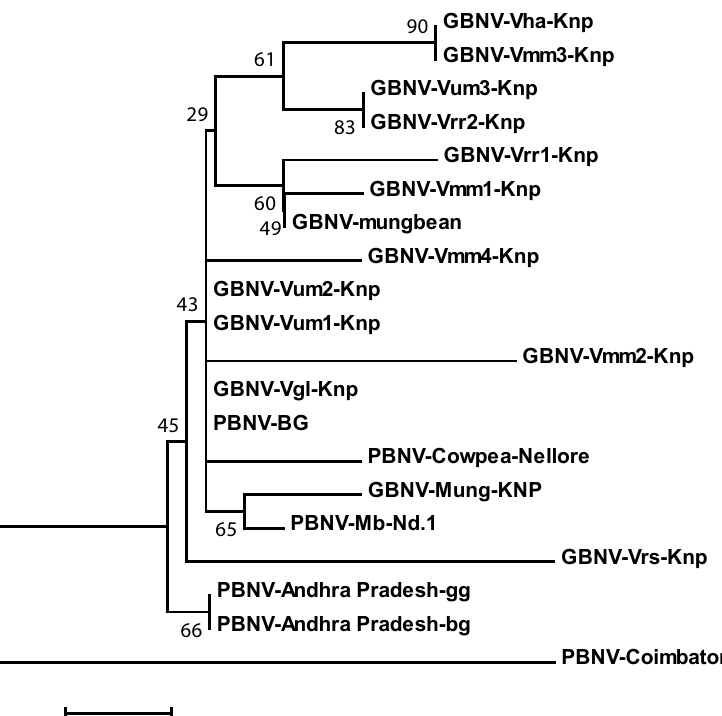
Figure 2. Phylogeny was inferred using Neighbor-Joining method of the GBNV isolates obtained in this study from wild Vigna species and sub-species and the GBNV isolates from Vigna species already available. The optimal tree with the sum of branch length = 0.12182971 is shown. The evolutionary distances were computed using the p-distance method and are in the units of the number of amino acid differences per site. The analysis involved 20 nucleotide sequences. Evolutionary analyses were conducted in MEGA5. Details of the isolates are given in Table